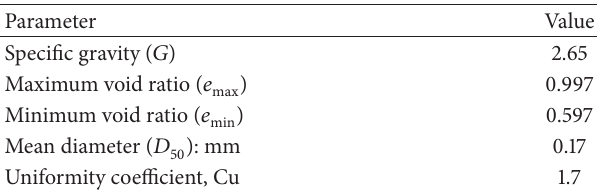
Table 1: Properties of the Toyoura sand used in this